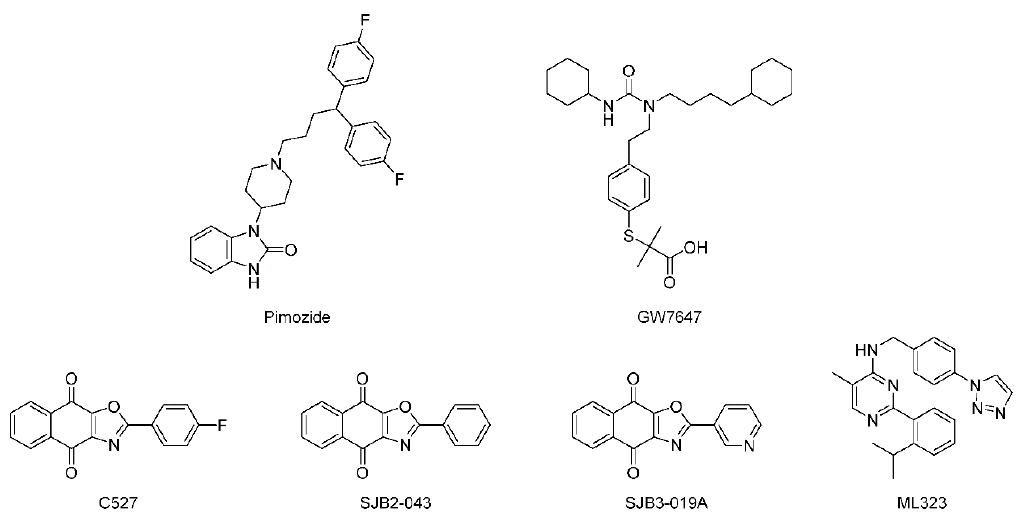
Figure 5. Structures of representative USP1 inhibitors.